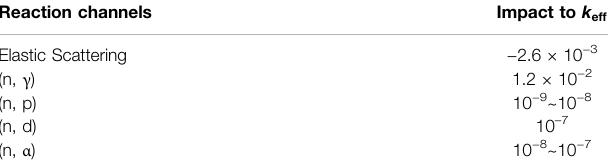
TABLE 7 | Assessed effect of C-12